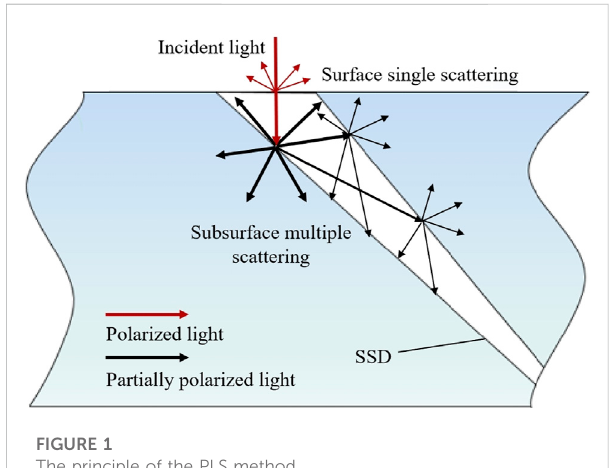
FIGURE 1 The principle of the PLS method.